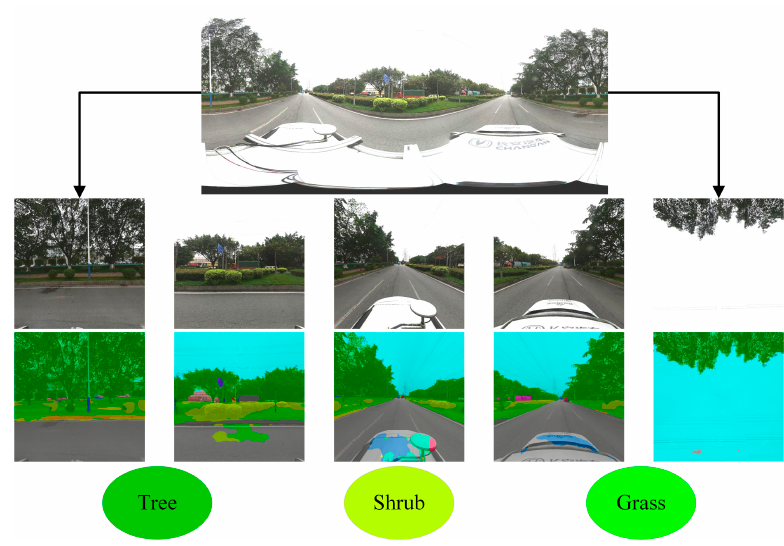
Figure 3. Extraction results of vegetation types from street view images.